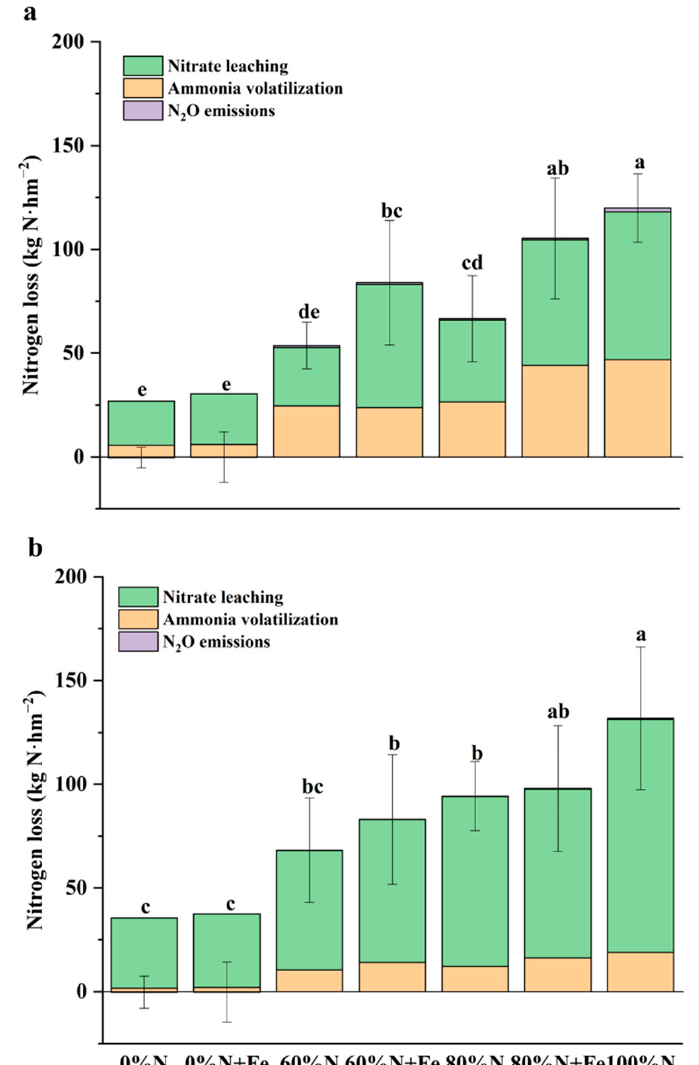
Figure 5. Nitrogen losses through ammonia volatilization, nitrous oxide emissions, and leaching N from a paddy field under various nitrogen fertilization rates with or without iron amendment in 2019 ( a ) and 2020 ( b ). the conventional N fertilization rate (315 kg N hm − 2 season − 1 ) for rice in the lower Yangtze River Delta is 100%N. Fe was applied at 5000 kg hm − 2 as iron powder (>99% purity) when the field experiment was initiated. Treatments that have the same letter above their bars (means ± SD, n = 4) are not significantly different at p < 0.05 as determined by analysis of variance (one-way ANOVA), followed by least significance difference (LSD) post hoc